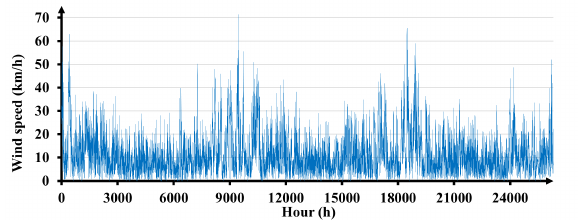
Fig. 3. Wind speed in Basel from 2018 to